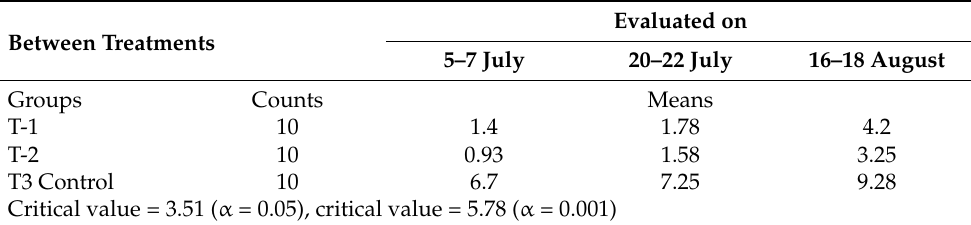
Table 5. The Tukey–Kramer multiple-comparison test on the different treatments and different time